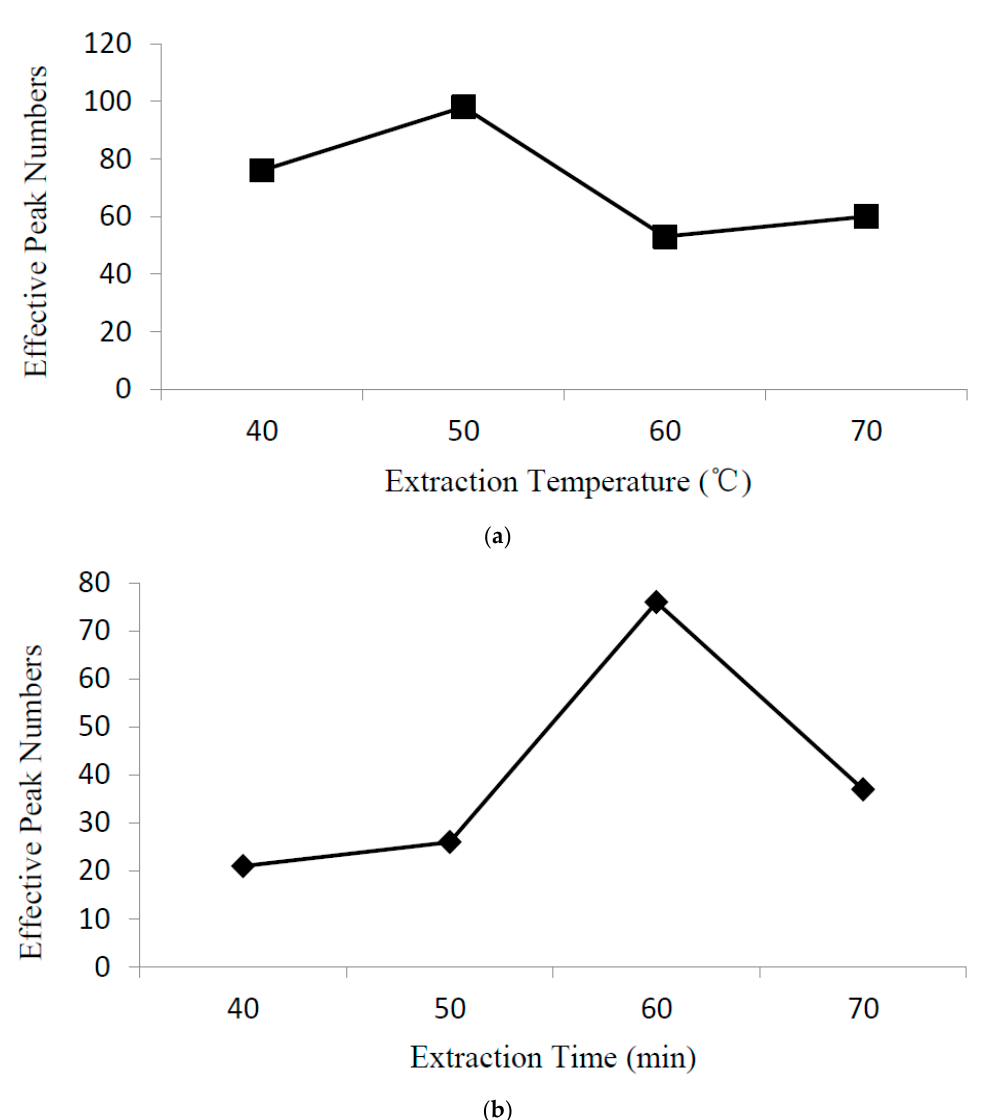
Figure 1. Effects of extraction temperature and time on extraction efficiency.